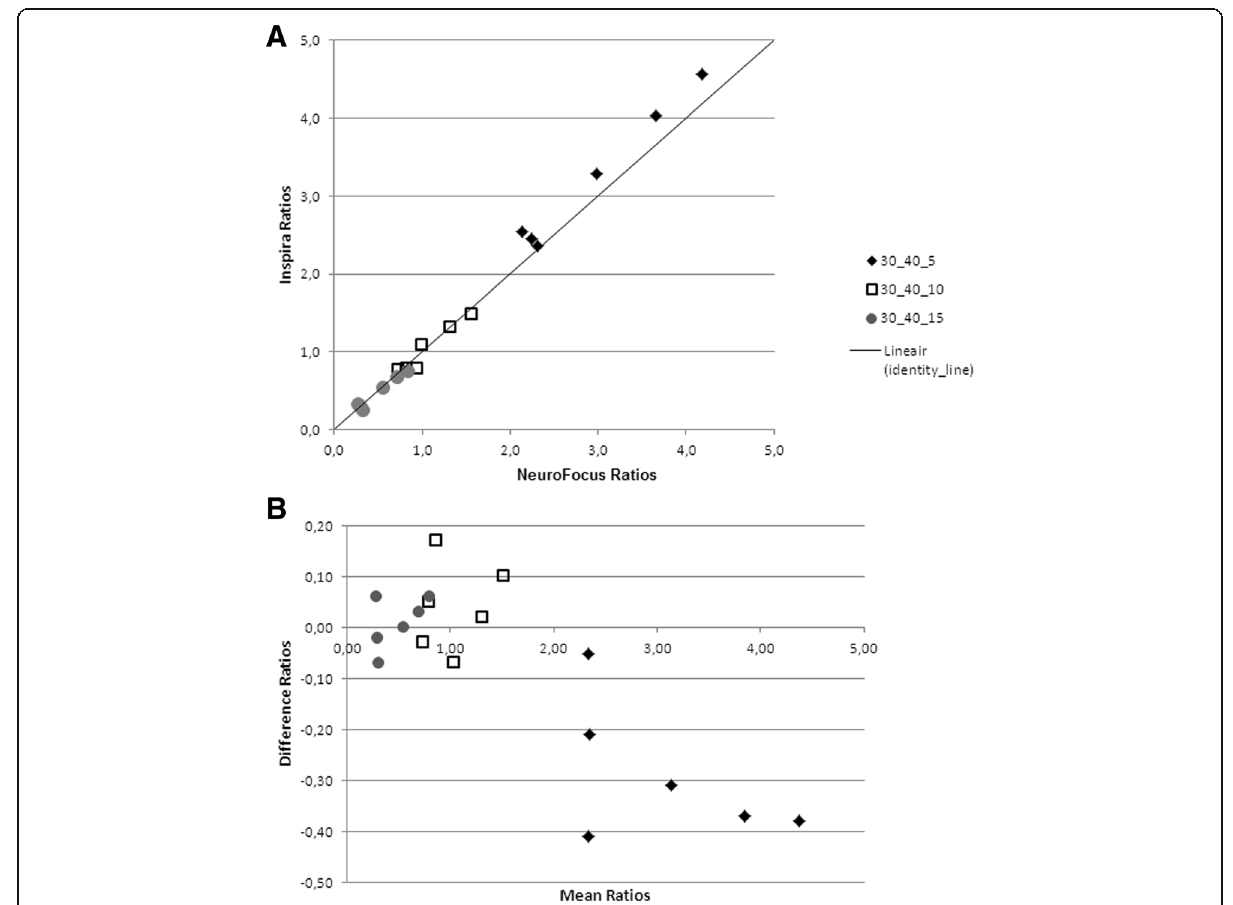
Fig. 3 Scatterplot of [ 123 I]FP-CIT binding ratios in the caudate nucleus and putamen on the InSPira and NeuroFocus system in phantom data. a Scatterplot of specific to non-specific [ 123 I]FP-CIT binding ratios in the caudate nucleus and putamen of data obtained on the InSPira ( y -axis) and NeuroFocus ( x -axis) system for the striatal phantom. b Bland-Altman plot with mean ratios on the two systems on the x -axis and the differences between the two systems on the y -axis (subtracting InSPira from NeuroFocus values). All data fell between the limits of agreement (±1.96 SD; not